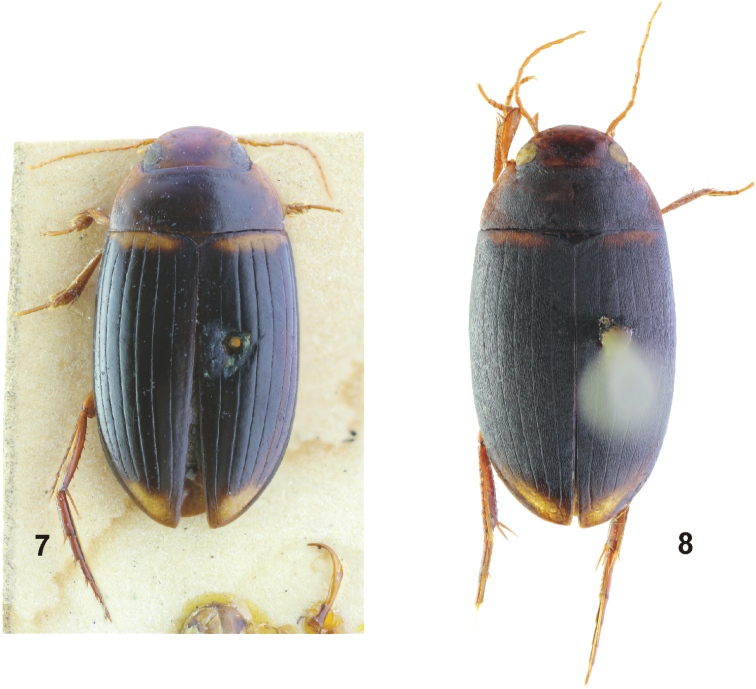
Habitus of Copelatus7C.
tulagicus Guignot, 1942 (holotype; TL: 6.5 mm) 8C.
tulagicus (striolate female, Guadalcanal; TL: 6.1 mm).